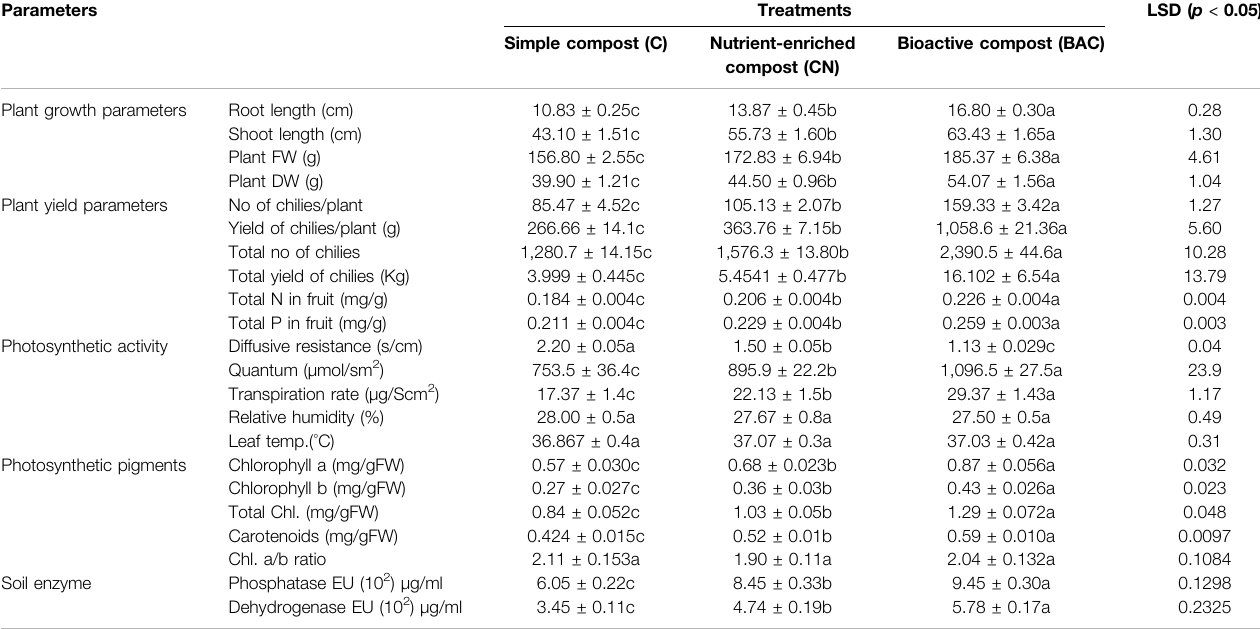
TABLE 6 | Effect of bioactive compost on growth parameters of chilies grown in small tunnel for 2 years (2 years averaged data). Parameters Treatments LSD ( p <